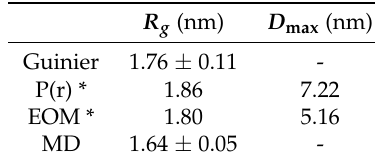
Table 3. Ensemble averages of R g and D max (if applicable) as obtained from various